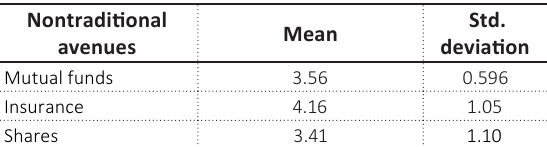
Table 5. Mean preference for investment